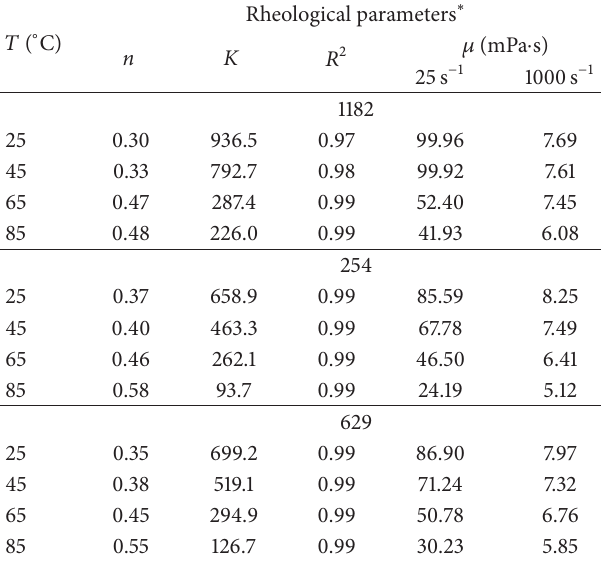
Table 6: Values for the flow index ( 𝑛 ), consistency index ( 𝐾 ), correlation coefficients ( 𝑅 2 ), and apparent viscosities of the xanthan gums obtained from the aqueous extract of the shrimp shell by strains of Xanthomonas campestris at different